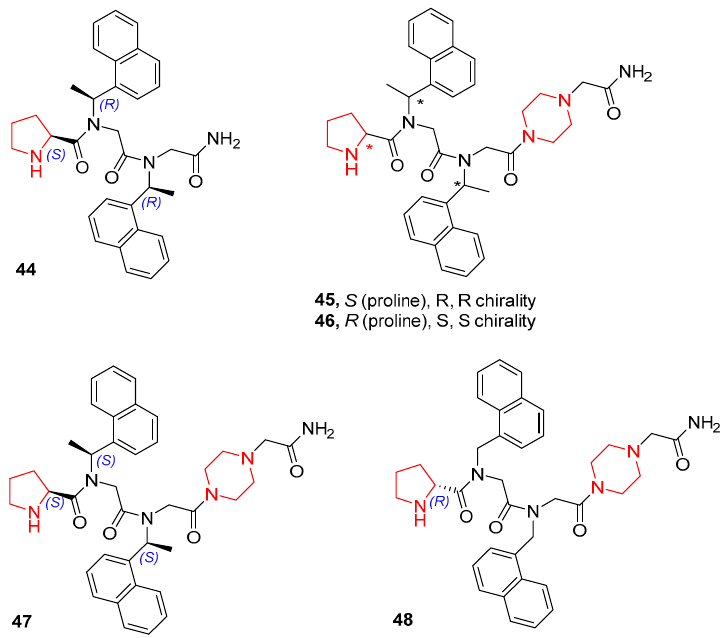
Figure 7. Structures of β -turn peptoids 44 – 48 .